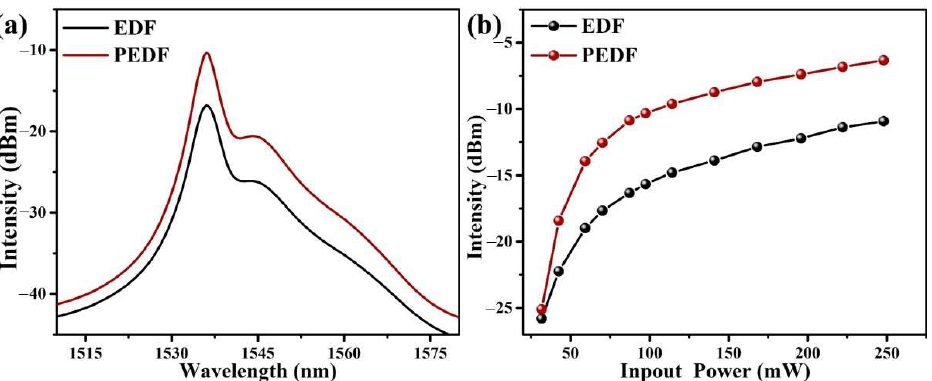
Figure 10. ( a ) The fluorescent spectra of EDF and PEDF under the pump at 980 nm with the length of 7.5 m; ( b ) the relationships between the input power and the luminescence intensities for EDF and PEDF.